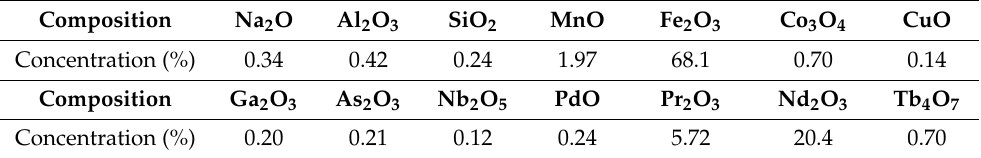
Table 2. Chemical composition of NdFeB magnet powders determined by XRF.